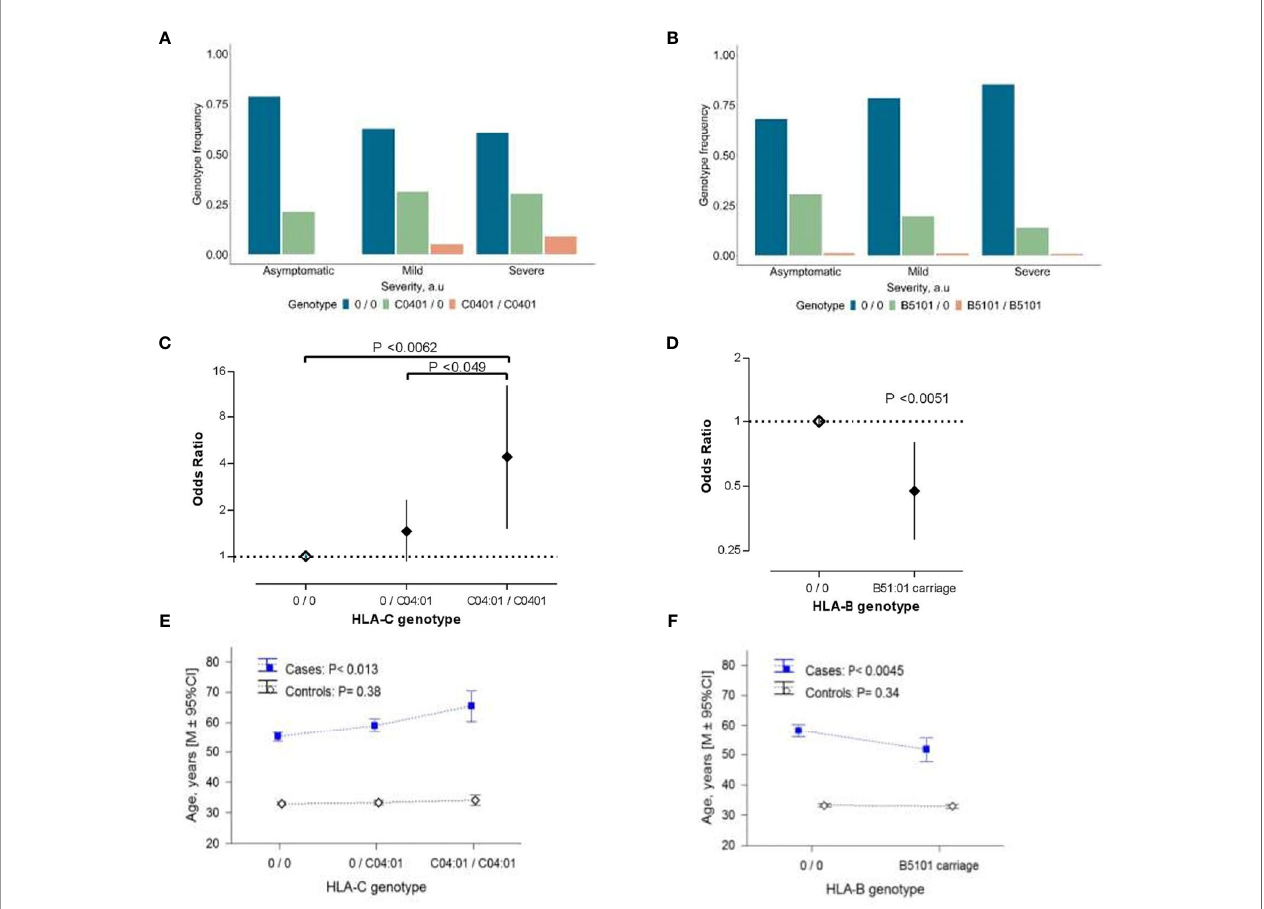
FIGURE 1 | The association of HLA class I alleles with COVID-19 severity. (A, B) Allelic distribution of HLA-C*04:01 (A) and HLA-B*51:01 (B) in COVID-19 patient subgroups with asymptomatic (n=75), mild/moderate (n=102), severe (n=122) manifestation of the disease. (C, D) COVID-19 disease severity risk associated odds ratio (OR) of HLA- C*04:01 (C) and HLA-B*51:01 (D) variations in the ordinal logistic regression analyses. Error bars represent 95% con fi dence intervals (95% CI) of OR. Data of HLA-C genotypes are the result of the ordinal logistic regression analyses using codominant model for visualization purposes. (E, F) Age distribution in the COVID-19 patients and controls from the general population associated with the allelic-load of HLA-C*04:01 (E) and HLA-B*51:01 carriage (F) . In (E, F) P-values were derived from ANOVA tests to analyze differential genotype effect separately in cases and controls. In (C – F) “ 0 ” denotes any other allele different from the allele of interest. In (E, F) control groups refers